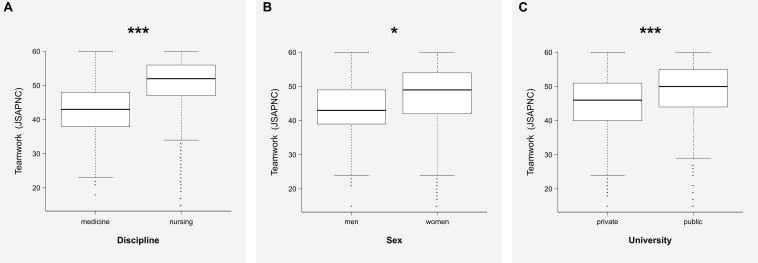
Comparisons of the global scores on the JSAPNC in the entire sample in relation to discipline (A), sex (B), and university (C). *p = 0.01; ***p < 0.001.